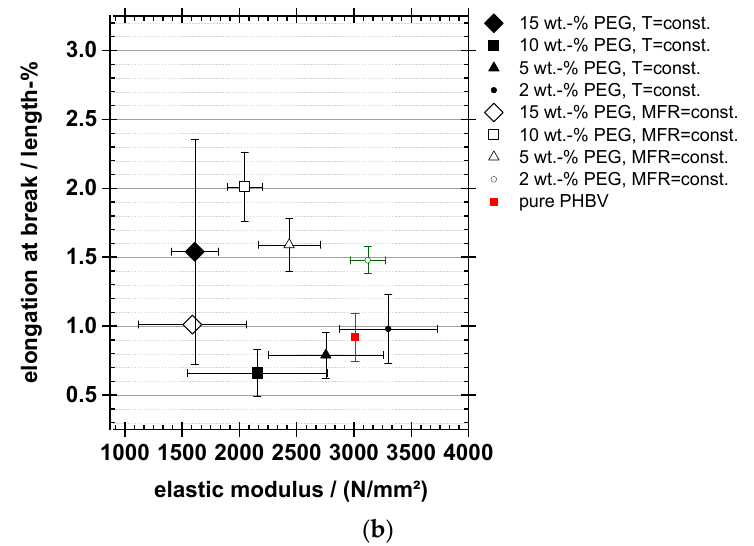
Figure 10. Elongation at break versus elastic modulus as function of plasticizer concentration: ( a ) of TEC; ( b ) of PEG. Comparison with results of Jost. MFR: melt flow rate during extrusion; T: temperature during extrusion.